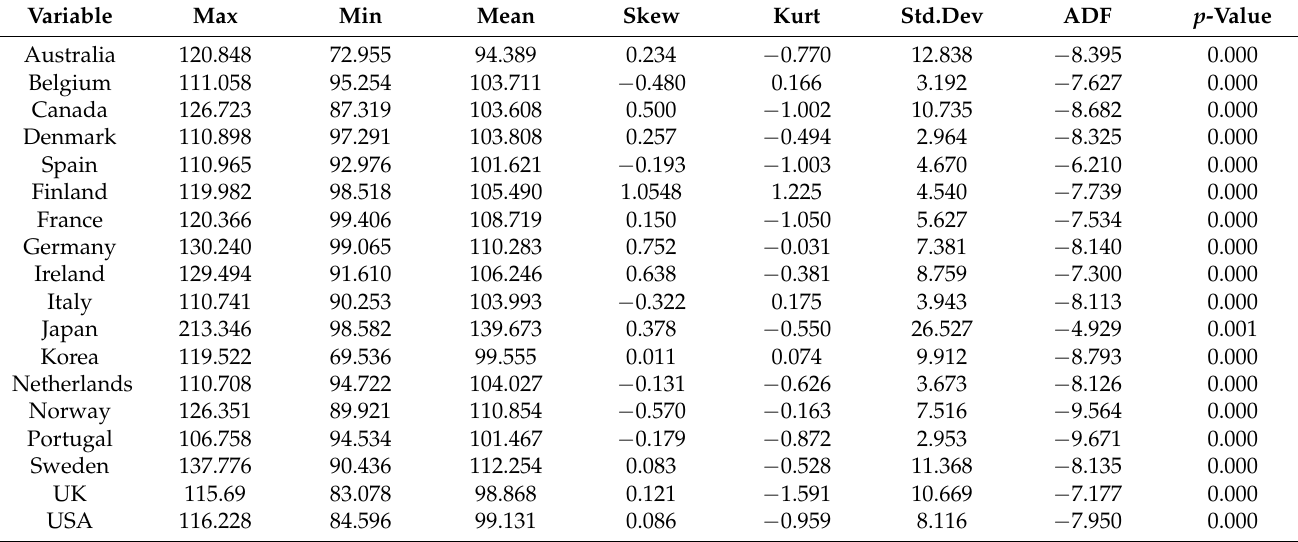
Table 1. Descriptive statistics of the real effective exchange rate index of OECD countries.